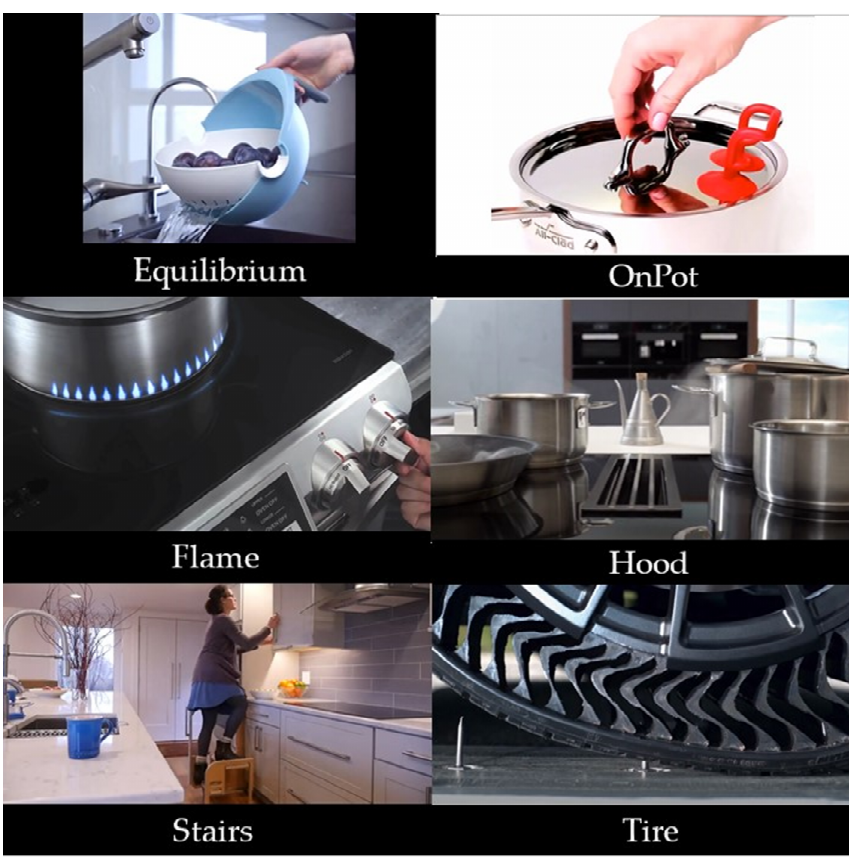
Figure 1. Pictures of the leveraged creative products.